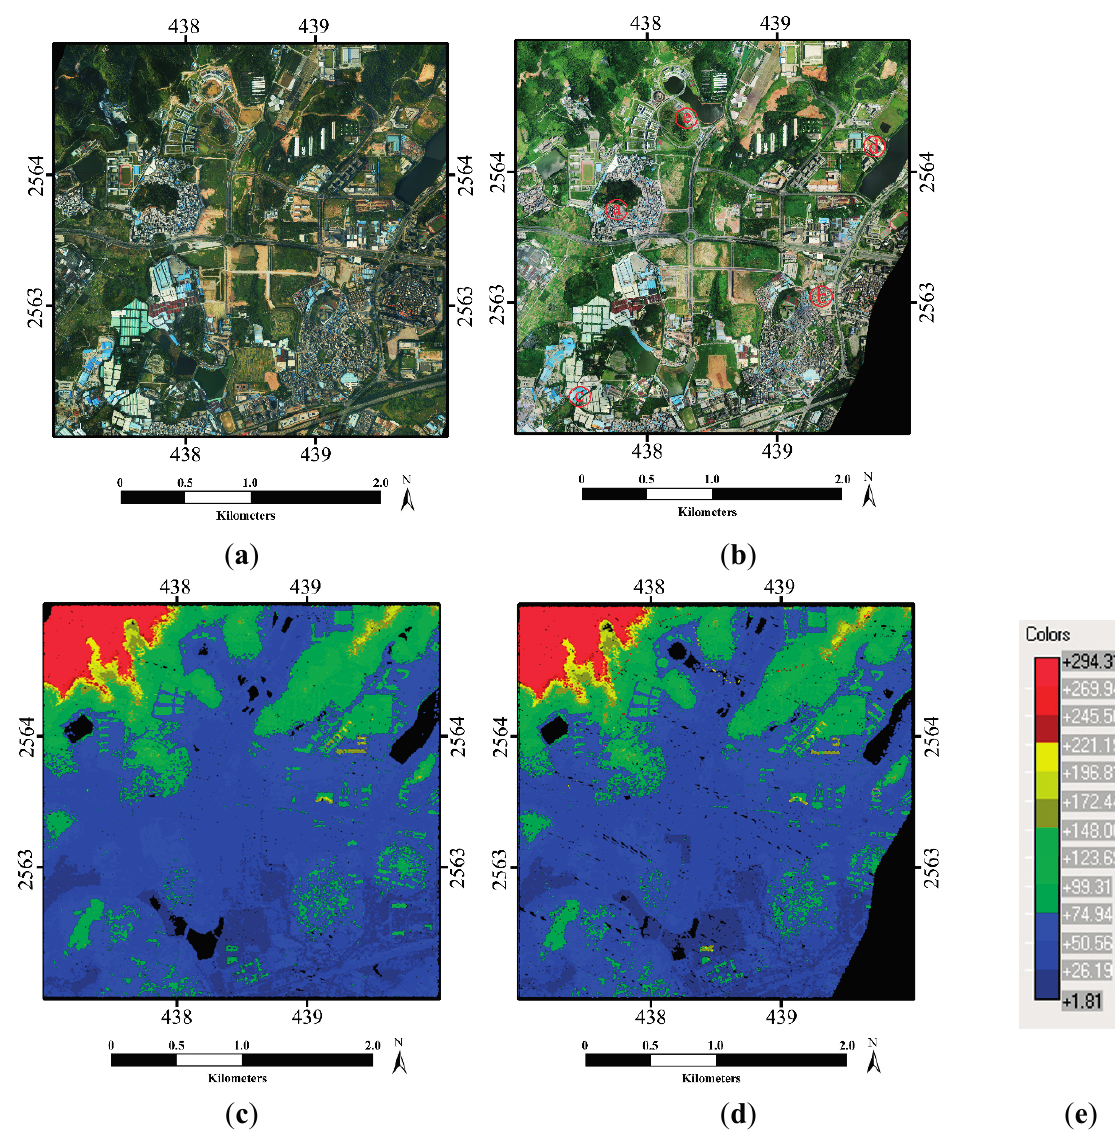
Figure 3. Experimental data sets: ( a ) old orthophoto, ( b ) new orthophoto, ( c ) old point cloud data, ( d ) new point cloud data, and ( e ) color display index of the elevation (unit: m).